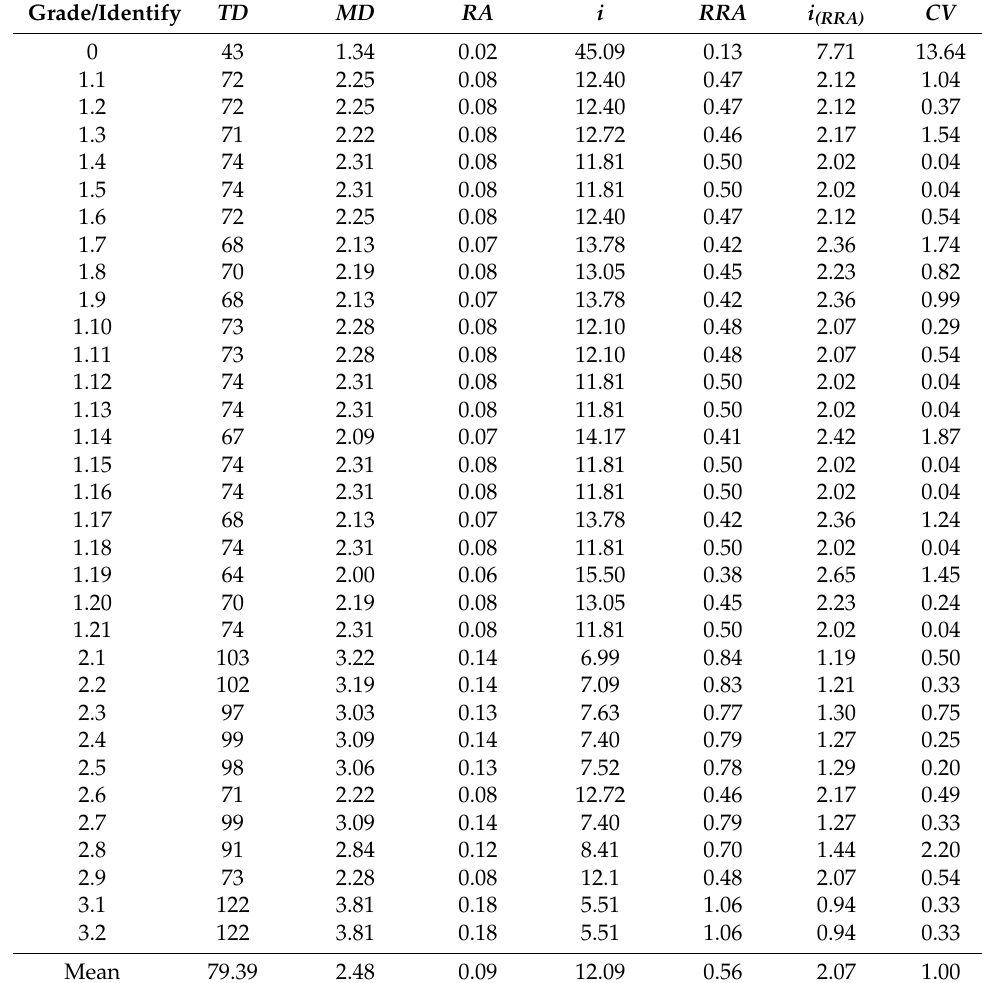
Figure 4. Tagh Bolandha House: ( a ) floor plans, ( b ) space access and connection plan and ( c ) space grading. Table 2. Tagh Bolandha House results.